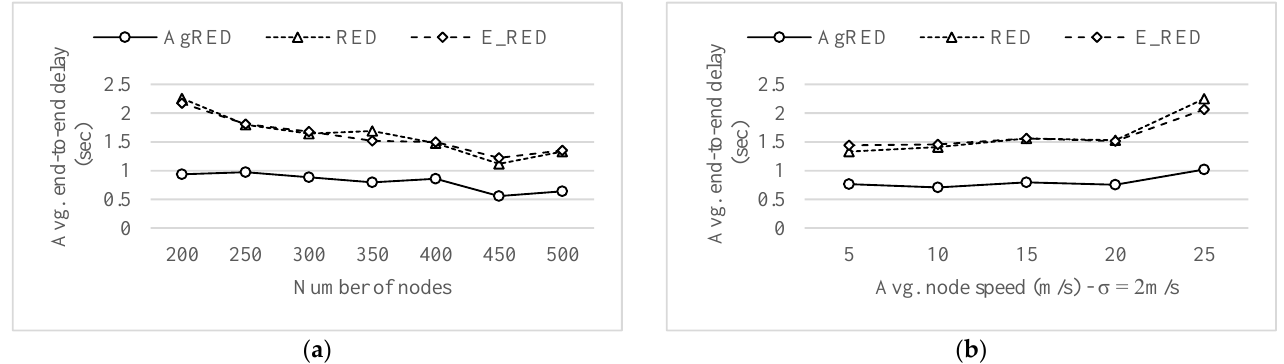
Figure 11. Average end-to-end delay for UDP with ( a ) varying number of nodes and ( b ) average node speed. Figure 11b shows the change in end-to-end delay with increasing average node speed (s), again highlighting the advantage of AgRED. Similar to Figure 11a, an overall improvement of 49.75% and 50% is observed in AgRED as compared to RED and E_RED, respectively. In other words, for the average speed of 25 m/s, the AgRED delay was found to be 1.018 sec as compared to 2.25 sec and 2.06 sec for RED and E_RED, respectively. Since end-to-end delay varies over time, presenting average values only might present an incomplete result by eliminating the outlier values. Therefore, a box plot is presented in Figure 12 representing the median and quartiles from the box, and the whisker represents values lower than quartile 1 and higher than quartile 3.